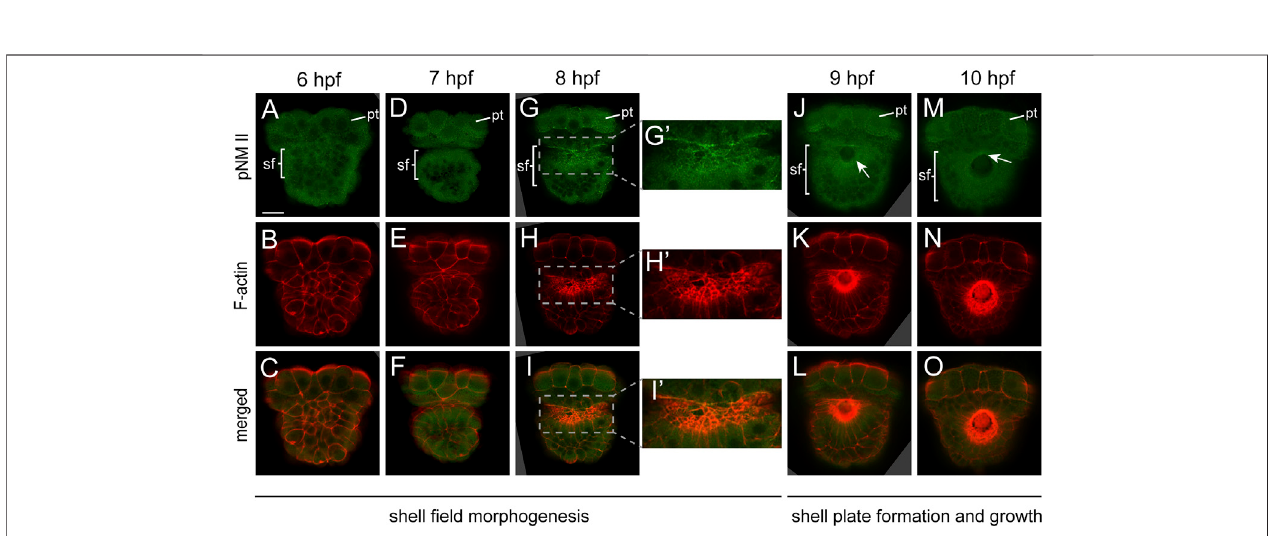
FIGURE 2 | Distribution of pNM II and F-actin during larval shell development. The pNM II was detected using a speci fi c antibody. Its signals could be best discerned at 8 hpf, which showed high degrees of colocalization with F-actin. When the shell plate was formed, the resolution was decreased, but the aggregation of both molecules in the shell plate region was supported (the white arrows in J and M indicate aggregated pNM II). Panels G ’– I ’ show magni fi ed images of the areas that are indicated by dashed rectangles in G – I . pt, prototroch; sf, shell fi eld. The bar represents 25 μ m.